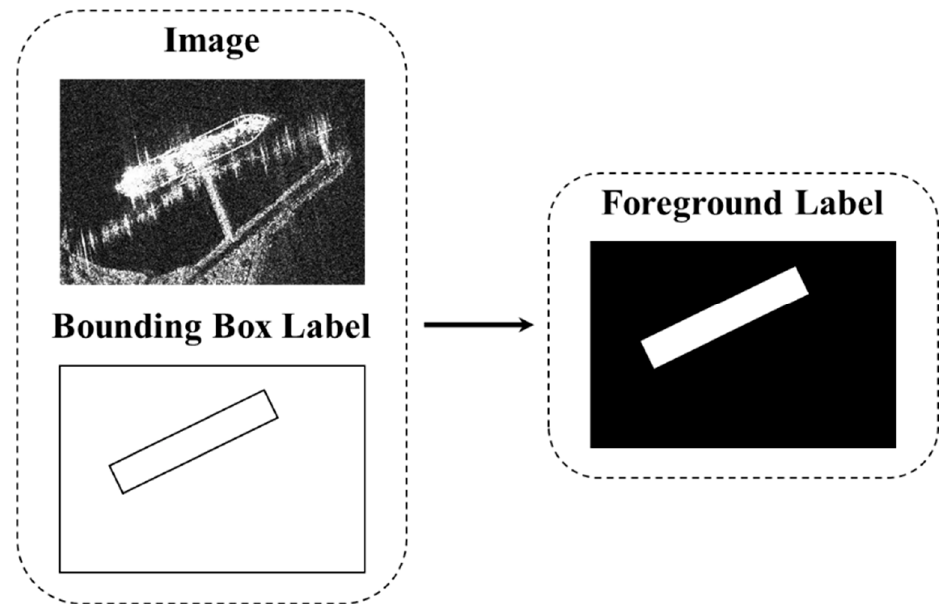
Figure 8. The schematic diagram of Foreground segmentation label generation: The Foreground segmentation labels are generated from the bounding box labels.